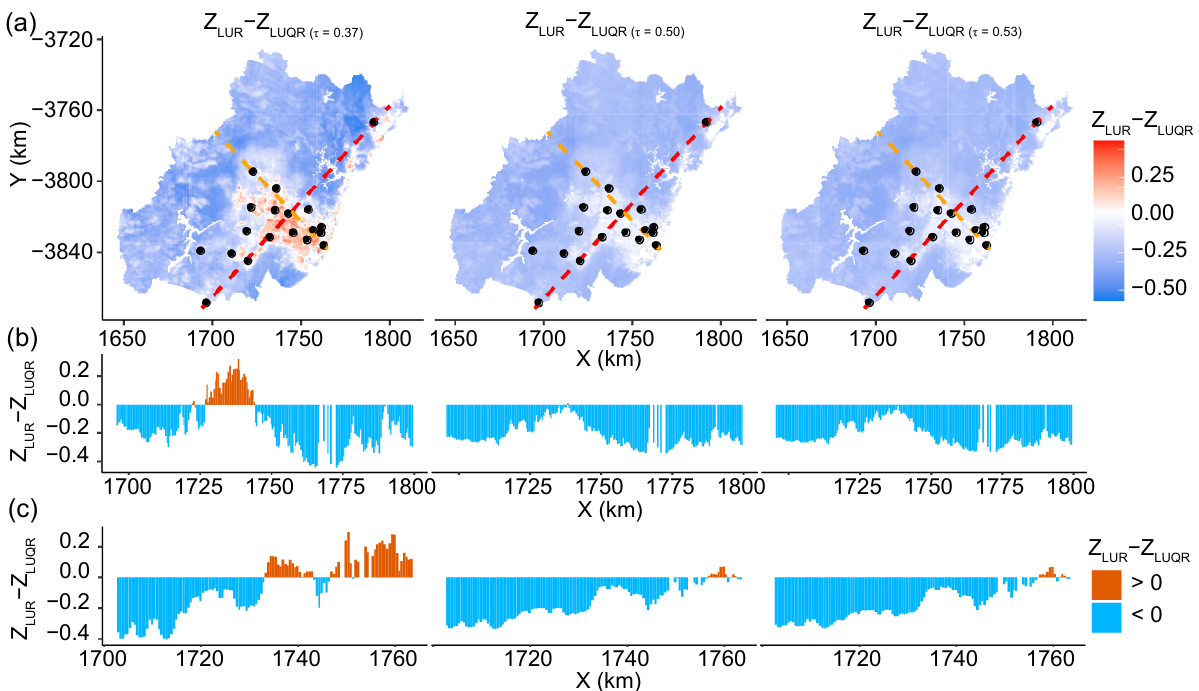
Figure 7. Density distributions of PM 2.5 concentrations predicted using LUQR and LUR models.